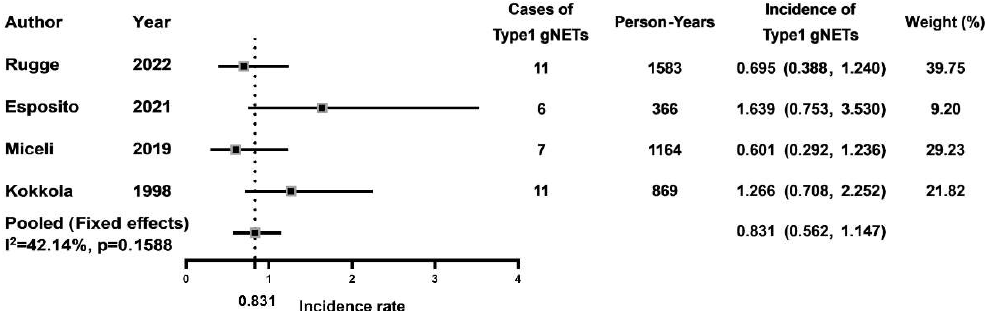
dence rate of type-1 gNETs in AMAG patients was 0.83% (95% CI: 0.56–1.15) per person- year.